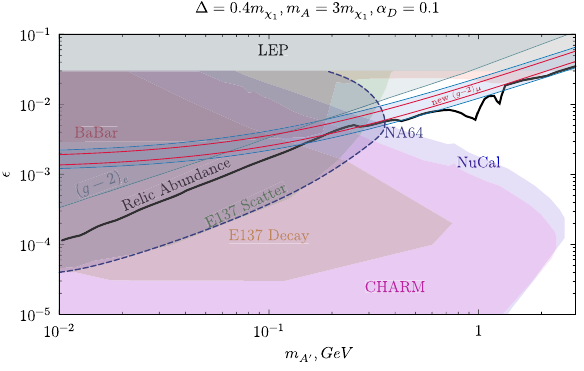
Fig. 4 The NA64 90% exclusion limit for a new vector boson A (cid:2) with a coupling to electrons with decay mode A (cid:2) → χ 1 χ 2 (χ 2 → χ 1 e + e − ) . The limits were derived in the ( m A (cid:2) , ε ) assuming α D = 0 . 1, m A (cid:2) = 3 · m χ and a mass splitting ¯ f = 0 . 4. The red band shows the region of 1 parameter space within two sigma from the world average of ( g μ − 2 )/ 2 [3]. The blue band shows the same region before the results at Fermilab were published. Constraints from BABAR and E137 are also shown following the recasting done in Refs. [14,15], together with the bounds of NuCal and CHARM [37]. A thick black line shows the combination of parameters compatible with a DM thermal relic